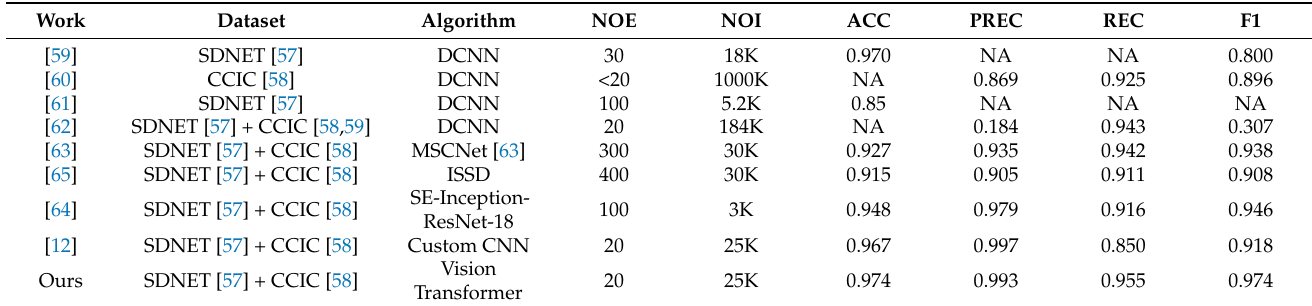
Table 6. Comparison of ViT model with SOTA DL